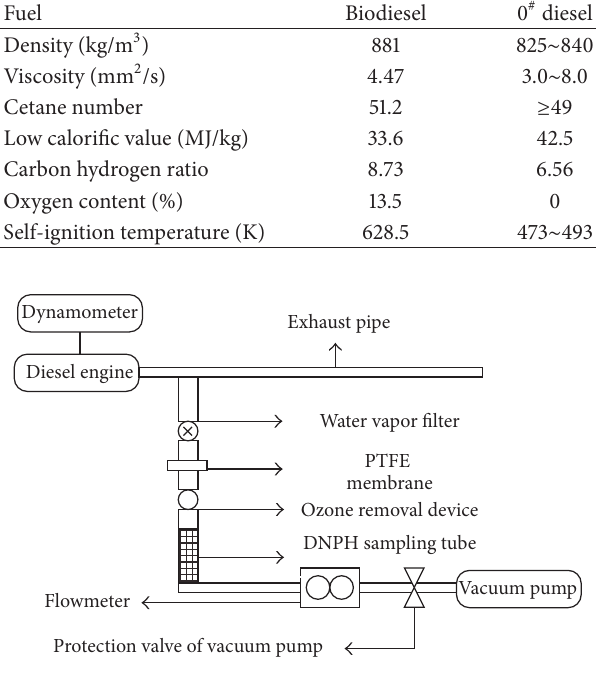
Figure 1: Diagram of sample collection